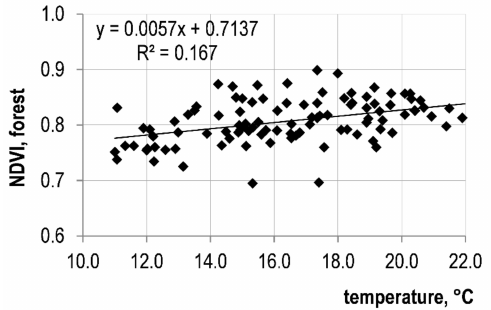
Figure 5. Relationship between NDVI and air temperature average monthly values in the growing season (May–September).